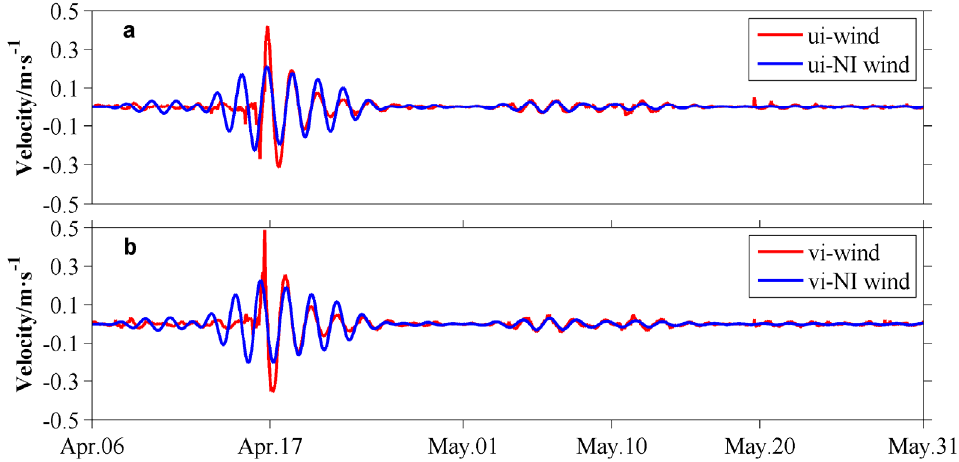
Figure 3. Components of the oceanic near-inertial current (unit in m / s) induced by wind stress (red lines) and the NIWS (blue lines) of Typhoon Neoguri at the observing station in April and May.